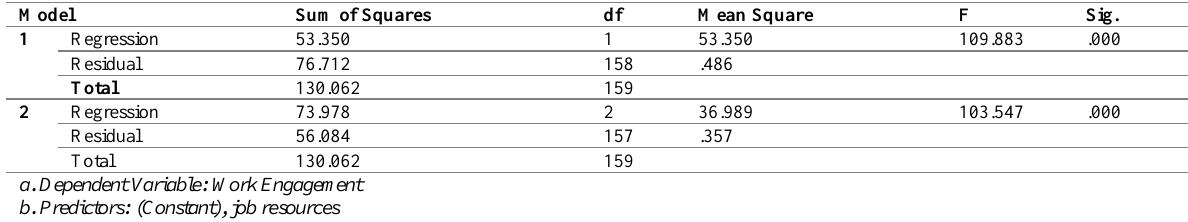
Table 6: ANOVA for the moderating effect of job